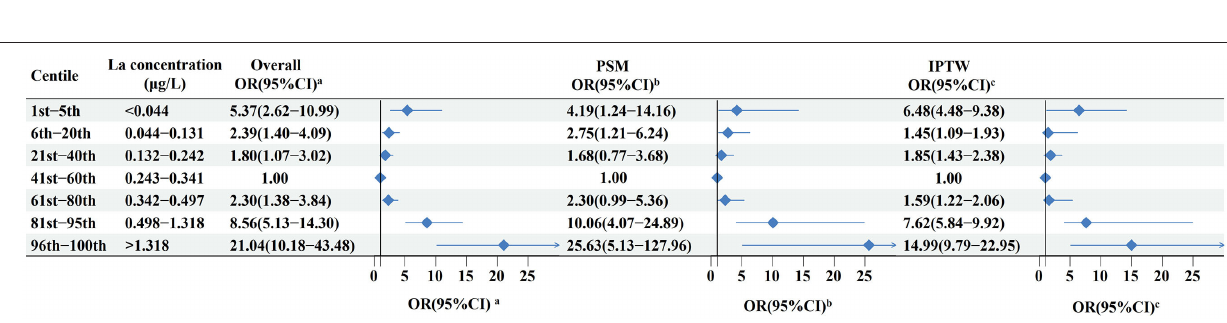
FIGURE 4 | Odd ratios for oral cancer according to categories of levels of La in the total study population, 1:1 PSM population, and IPTW population. (a) Calculated from multivariable logistic regression models, with adjustment for age, gender, occupation, education level, BMI, residence, family history of cancer, smoking, alcohol and tea drinking, as well as intake frequency of red meat, fish, seafood, vegetables, and fruits. (b,c) Calculated from conditional logistic regression